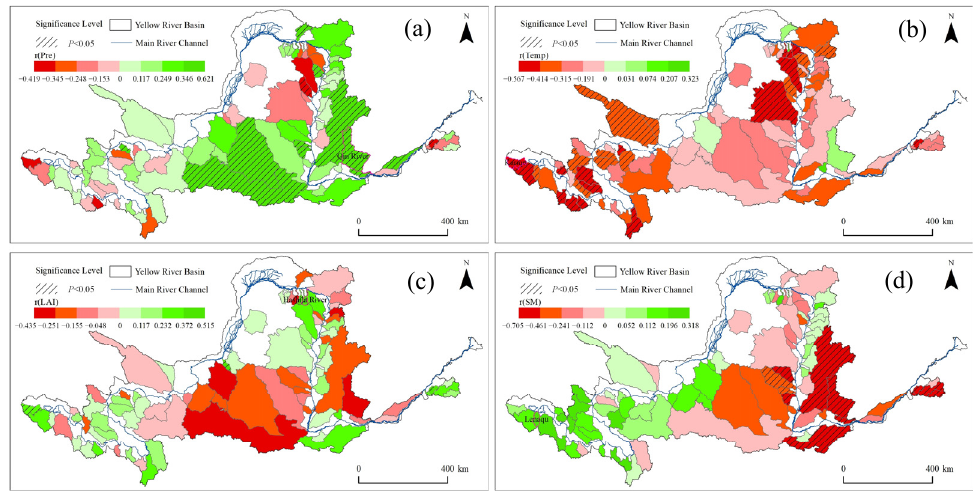
Figure 17. Correlation coefficients between the SWA and the Pre ( a ), Temp ( b ), LAI ( c ), and SM ( d ) for the seasonal water bodies in each sub-basin.